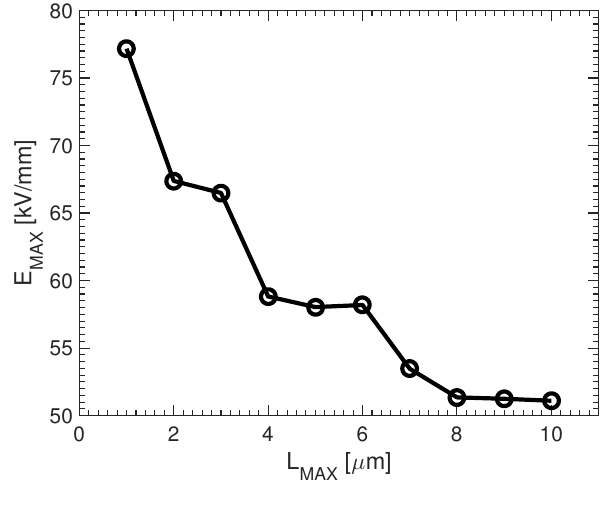
Figure 5: E MAX vs. L MAX